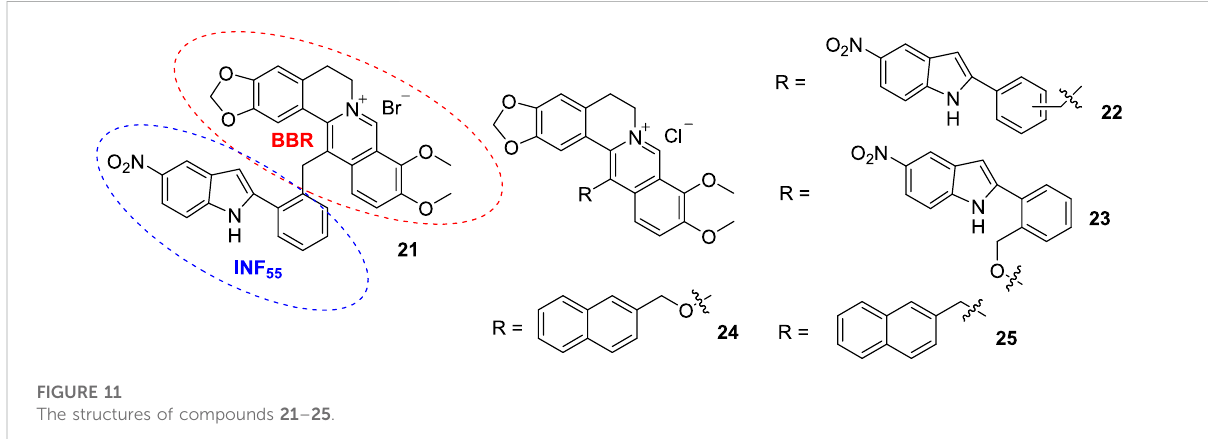
FIGURE 11 The structures of compounds 21 – 25